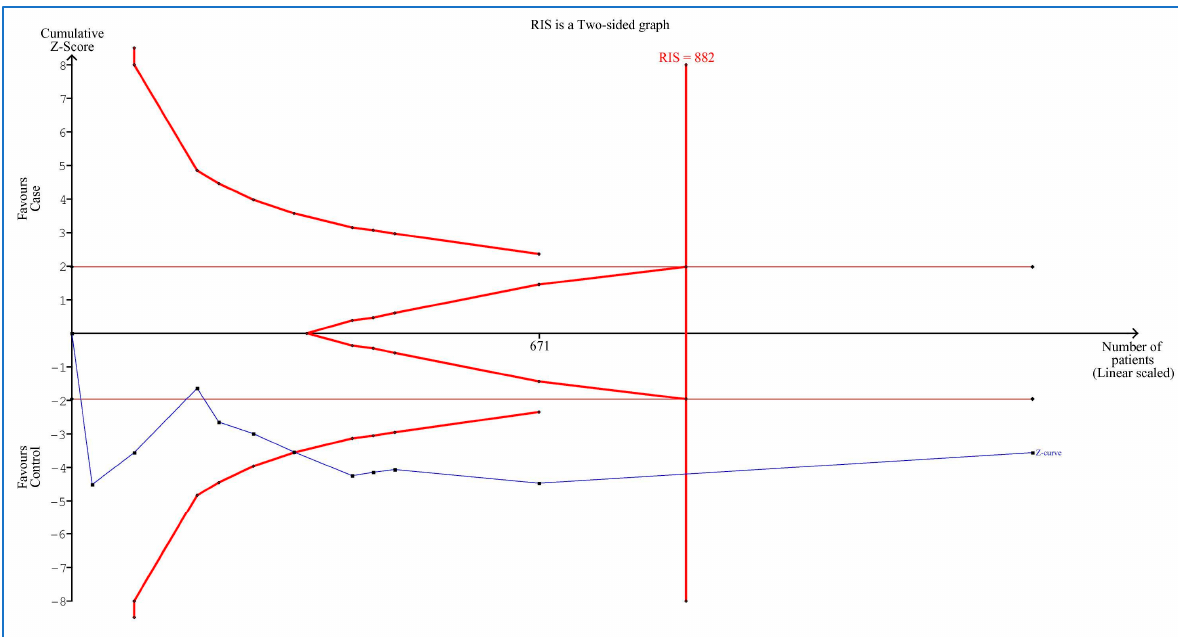
Figure 5. Trial sequential analysis in adults with obstructive sleep apnea compared to controls. The vertical red line shows the required information size (RIS). Horizontal brown lines shows conventional boundary for benefit (up) and for harm (down). Each black dot on the Z-curve (blue